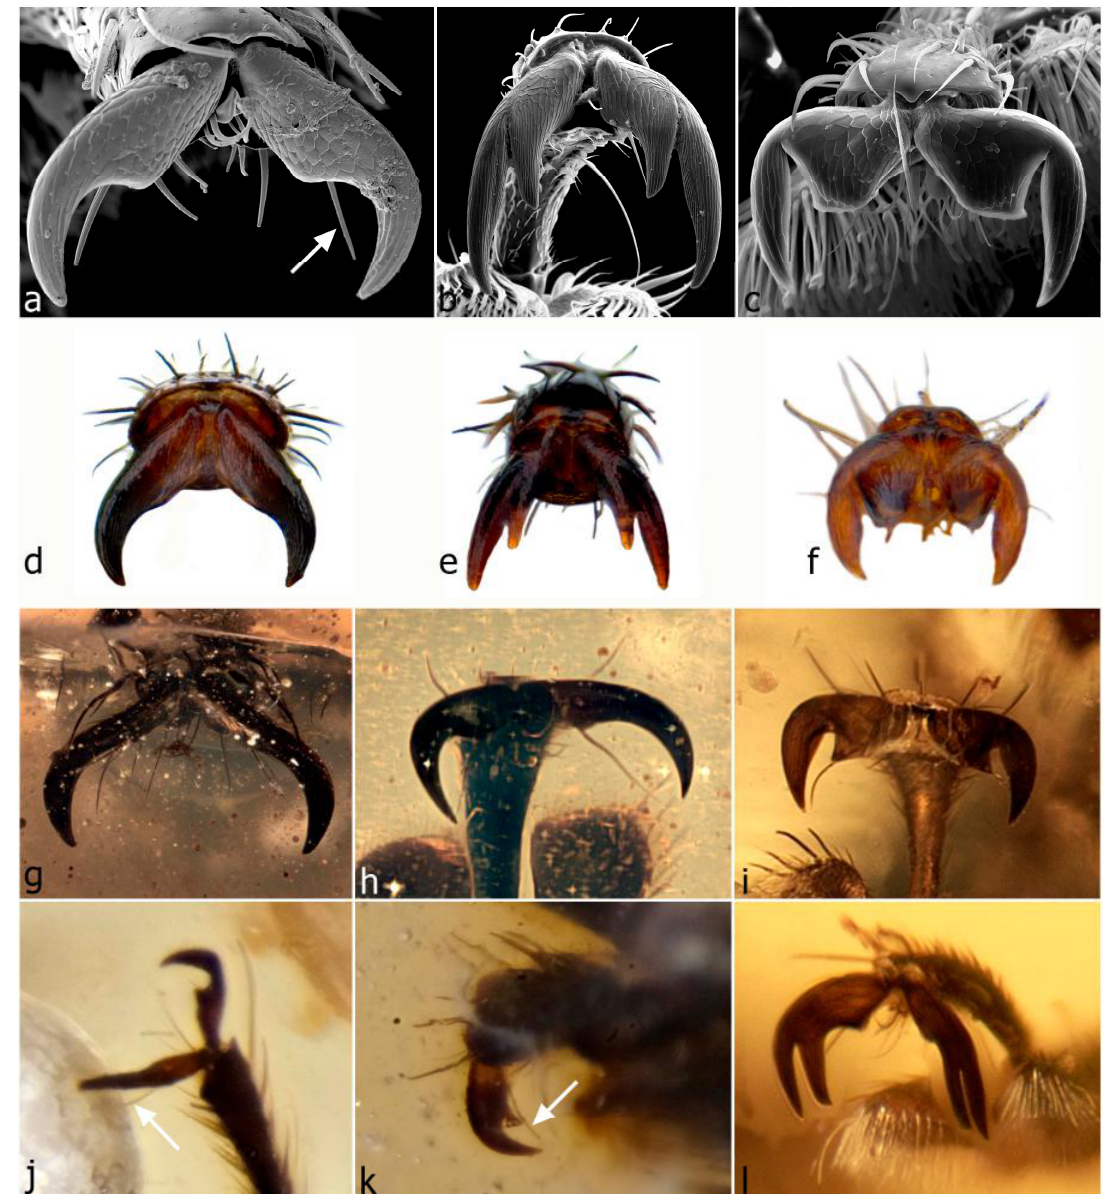
Figure 12. Tarsal claws in extant and Burmese amber weevils. Angulate, with ventrobasal seta (arrow), Car cf. condensatus (Caridae) ( a ); bifid, without ventrobasal seta, Telala sp. (Anthribidae) ( b ); laminate, without ventrobasal seta, Basiliorhinus araucariae (Nemonychidae) ( c ); simple, without ventrobasal seta, Hadrobelus undulatus (Belidae) ( d ); bifid, with ventrobasal seta, Ithycerus noveboracensis (Brentidae: Ithycerinae) ( e ); laminate, without ventrobasal seta, Rhodocyrtus cribripennis (Attelabidae) ( f ); simple, with ventrobasal seta, Cetionyx ursinus (Mesophyletidae) ( g ); angulate, with ventrobasal seta, Opeatorhynchus comans (Mesophyletidae) ( h ); dentate, with ventrobasal seta, Mekorhamphus gracilipes (Mesophyletidae) ( i ); dentate, with ventrobasal seta (arrow), Rhynchitomimus chalybeus (Mesophyletidae) ( j ); dentate, with ventrobasal seta (arrow), Calyptocis brevirostris (Mesophyletidae) ( k ); bifid and dentate, with ventrobasal seta, Myanmarus diversiunguis (Mesophyletidae) ( l ).